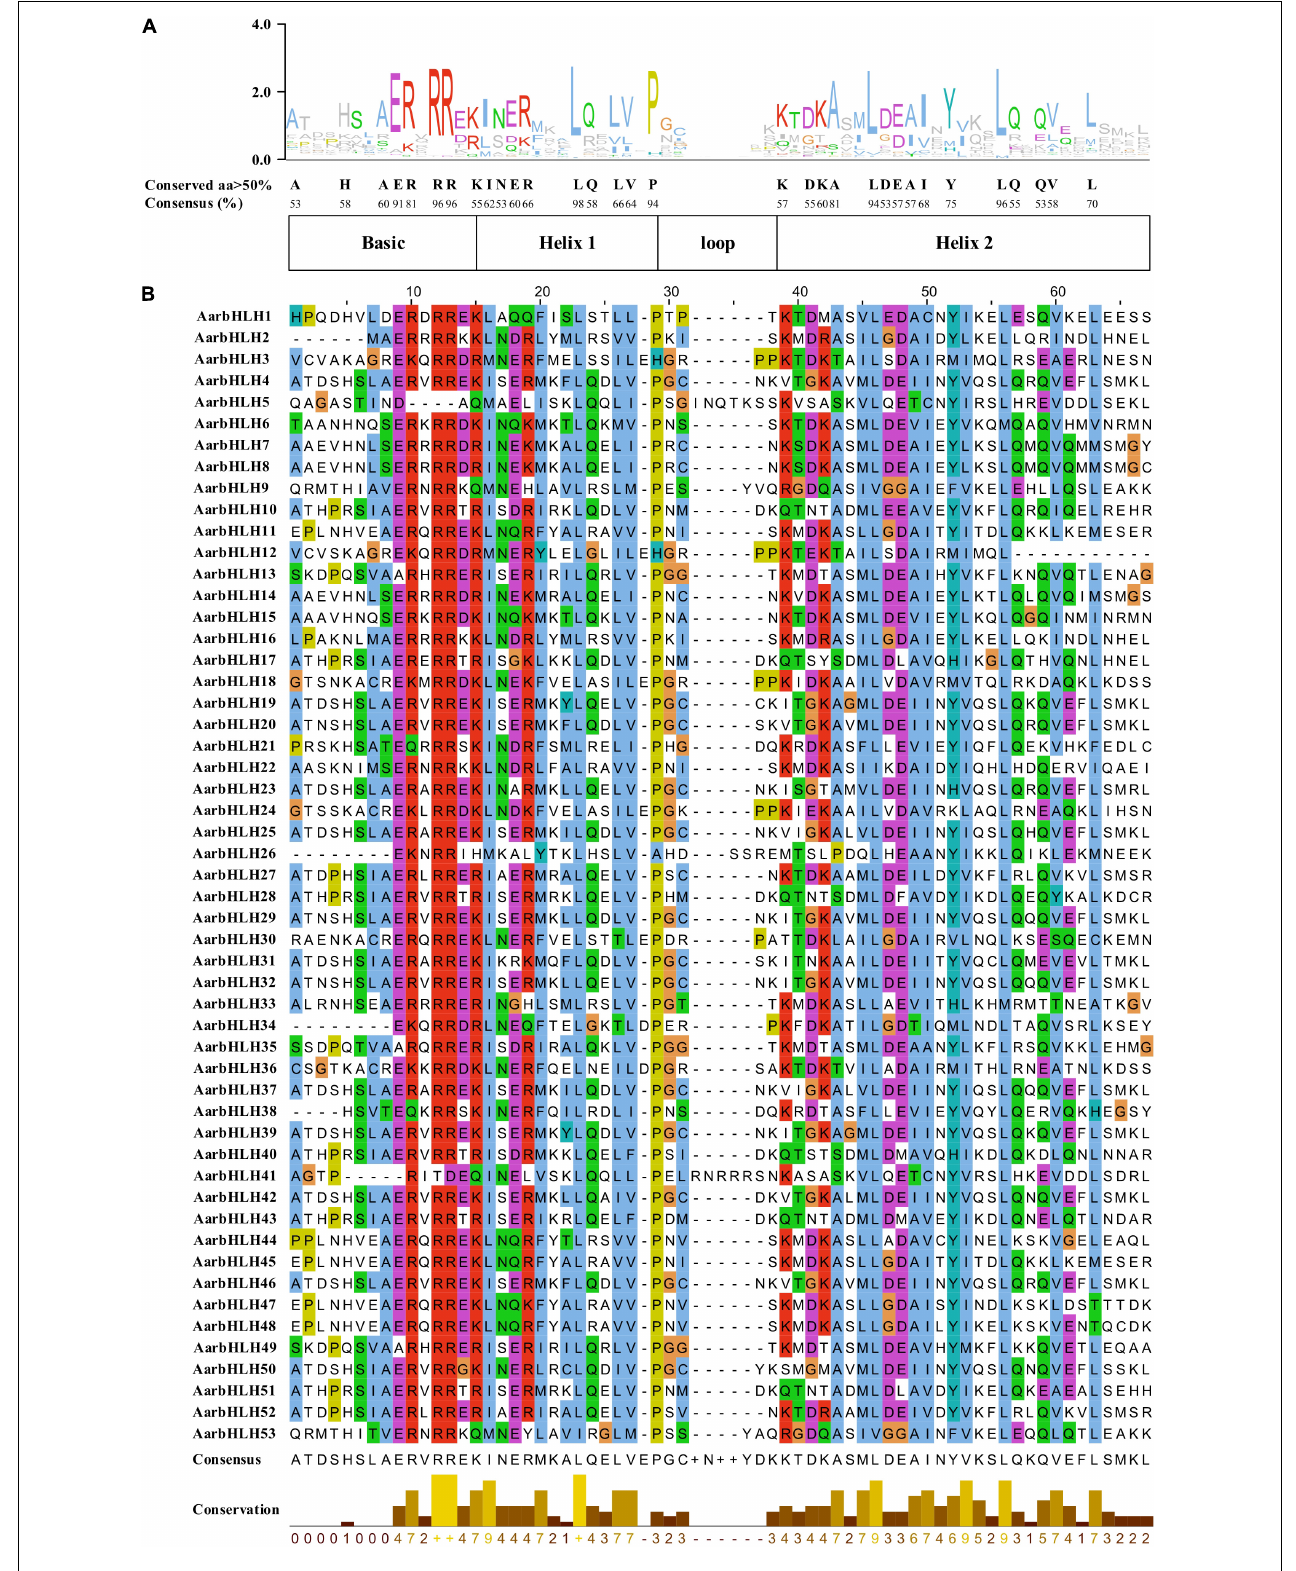
FIGURE 2 | The conserved bHLH domains of AarbHLH proteins in Artemisia argyi . (A) The sequence logo of the bHLH domain. The capital letters represent over 50% conservation of amino acids. (B) The distribution of the conserved bHLH domain in AarbHLH proteins.